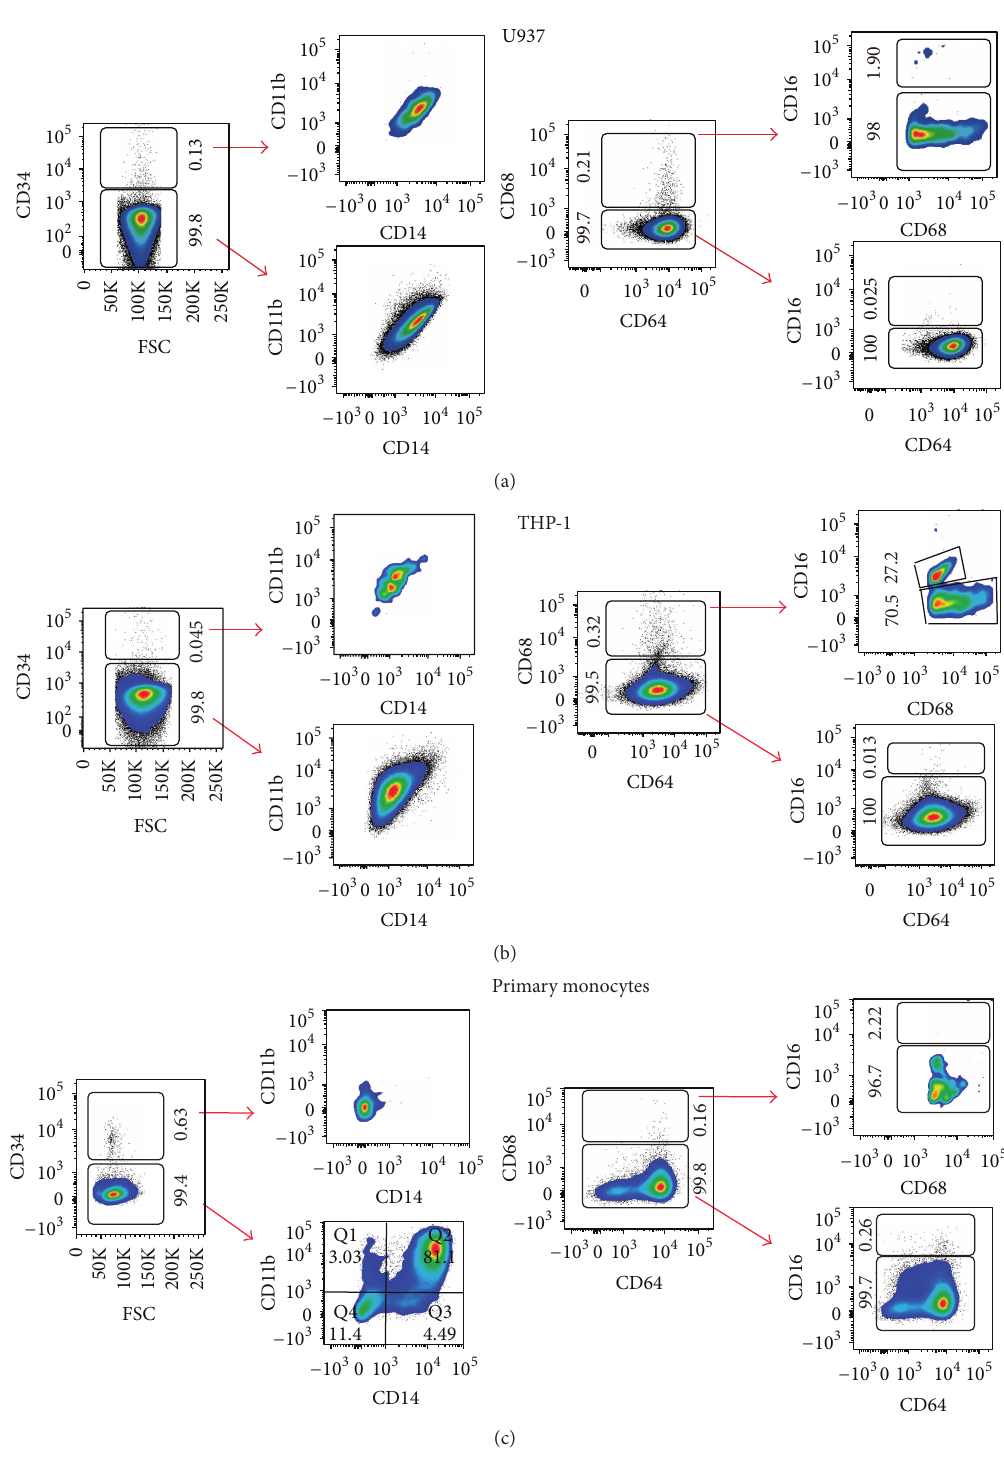
Figure 1: Phenotypic characterization of monocytic cell lines and primary monocytes. Dot blots representative of the flow cytometry analysis. Depicted are population percentages based on two marker panels: CD34, CD11b, and CD14 (left) and CD68, CD64, and CD16 (right) markers for (a) U937 cells, (b) THP-1 cells, and (c) primary monocytes. One donor is used as an example for primary monocytes although similar results were obtained with different donors and with different isolation batches. The phenotype found in most of the cells analyzed is basically the same for all three types of monocytes: CD 34 neg , CD 11 b pos , CD 14 pos , CD 68 neg , CD 64 pos , and CD 16 neg , which denotes a classical inactivated monocyte